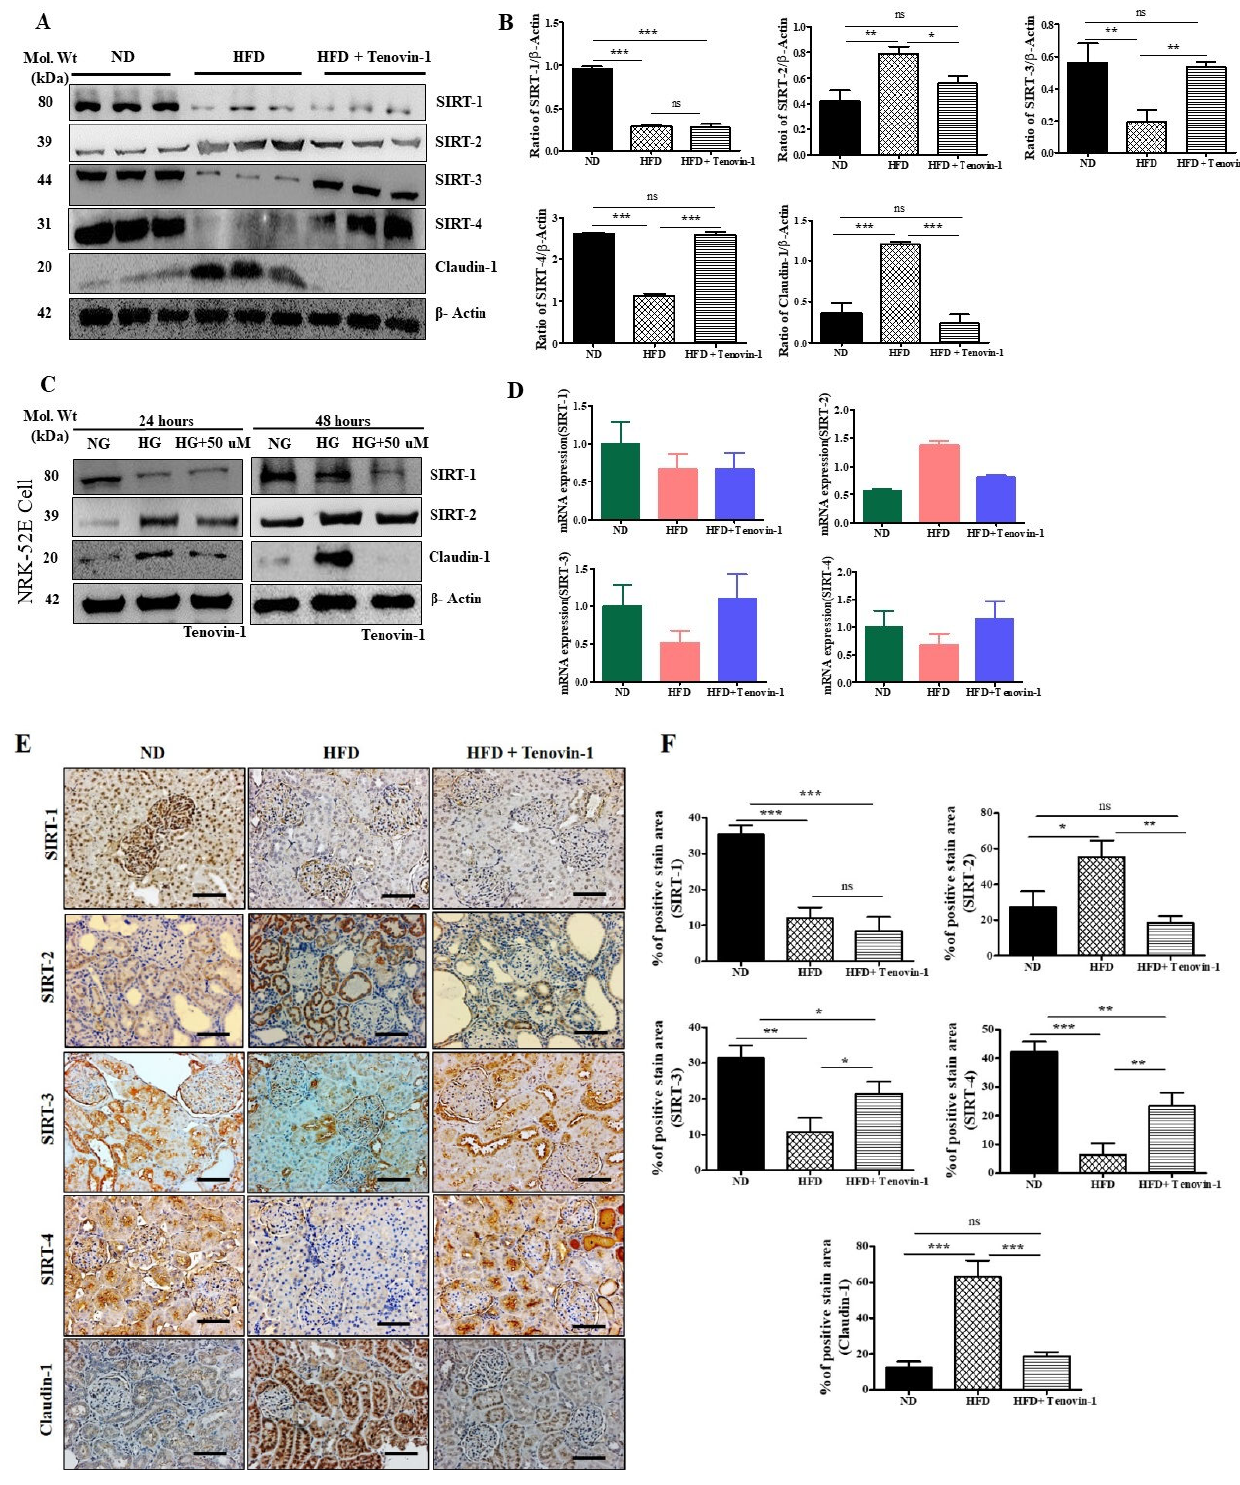
Figure 8. The effects of Tenovin-1 on SIRT and claudin-1 expression were measured by Western blot analysis using experimental rat models of HFD-induced diabetes. ( A ) The levels of SIRT1, SIRT2, SIRT3, SIRT4, and claudin-1 were analyzed using Western blotting in the kidneys of rats with HFD-induced diabetes. β -actin was used as the loading control. The outcomes of three different experiments were combined in the Western blotting results. ( B ) The band intensities were measured densitometrically. ( C ) Western blot analysis of SIRT and claudin-1 levels was carried out using the NRK-52E cell lysate. ( D ) mRNA expression levels of SIRTs (SIRT1, SIRT2, SIRT3, and SIRT4)